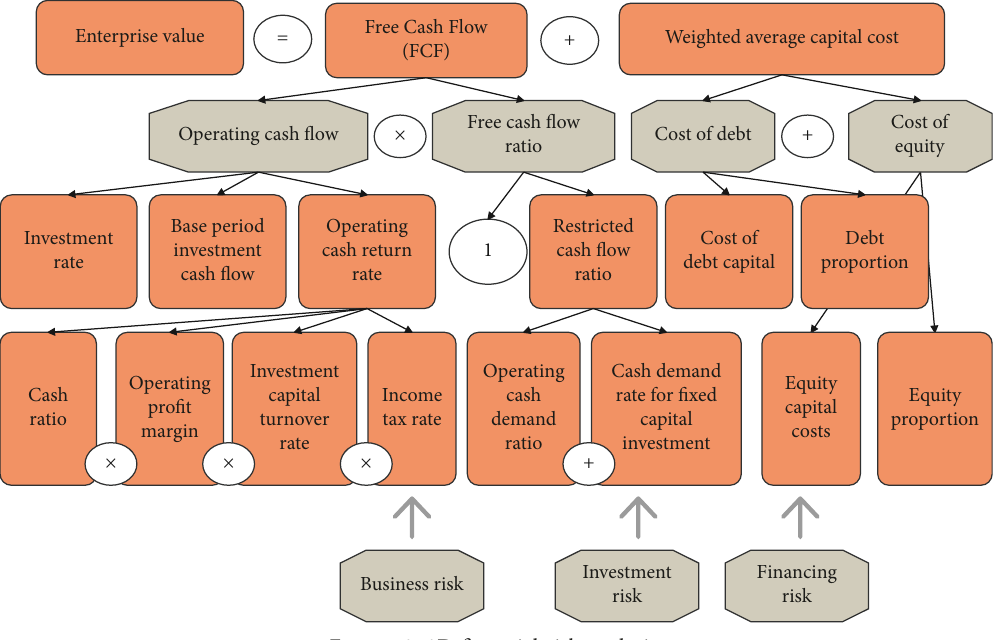
Figure 3: 3D financial risk